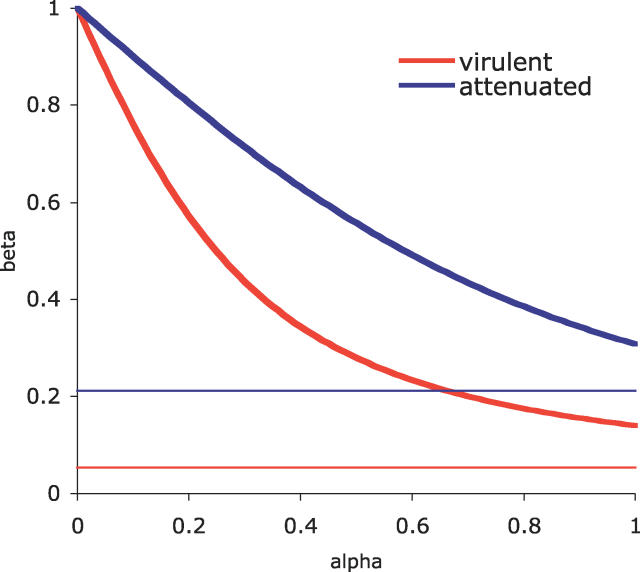
Extracellular versus Intracellular Control of Within-Host ProliferationWithin-host control contours (reproductive number R = 1) as a function of intracellular division parameter α
0 (normalised to a maximum of 1) and extracellular survival probability β. Thick lines are control contours assuming the density-dependent fission model (parameter values in Table 2). Thin lines are control contours assuming the gamma-distributed threshold model (parameter values in Table 1).